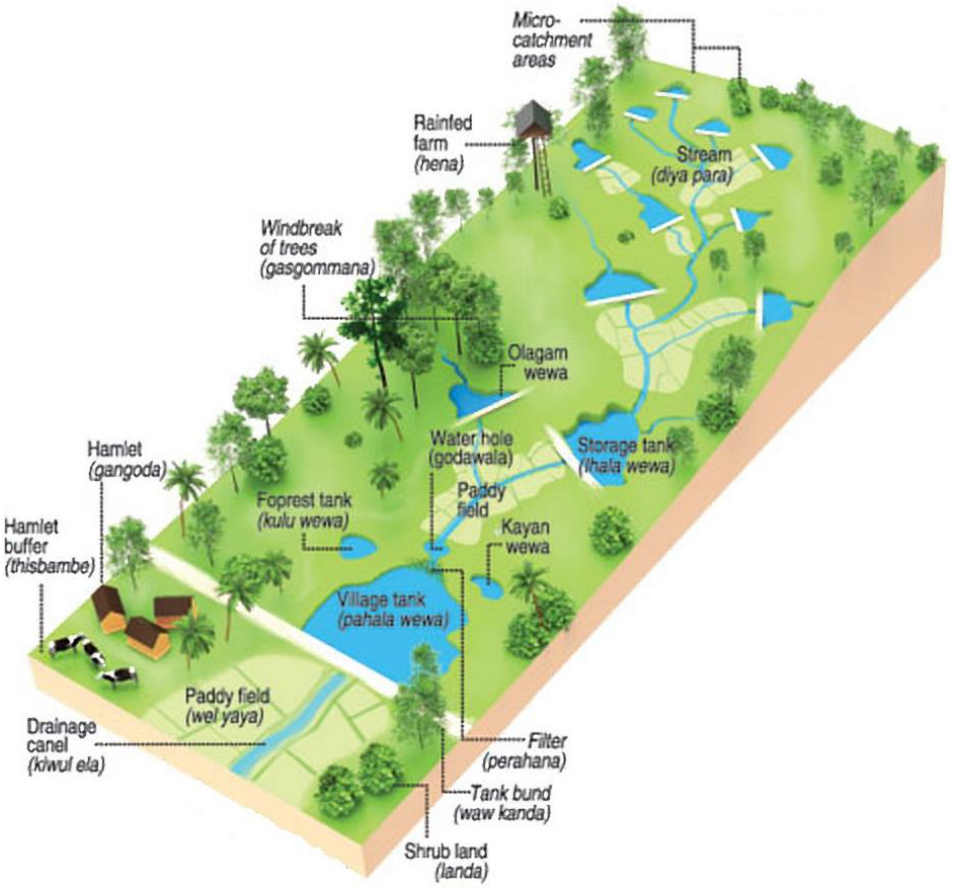
Figure 1. Schematic representation of a tank cascade system (the various components of the system are subtitled with their Singhalese names).